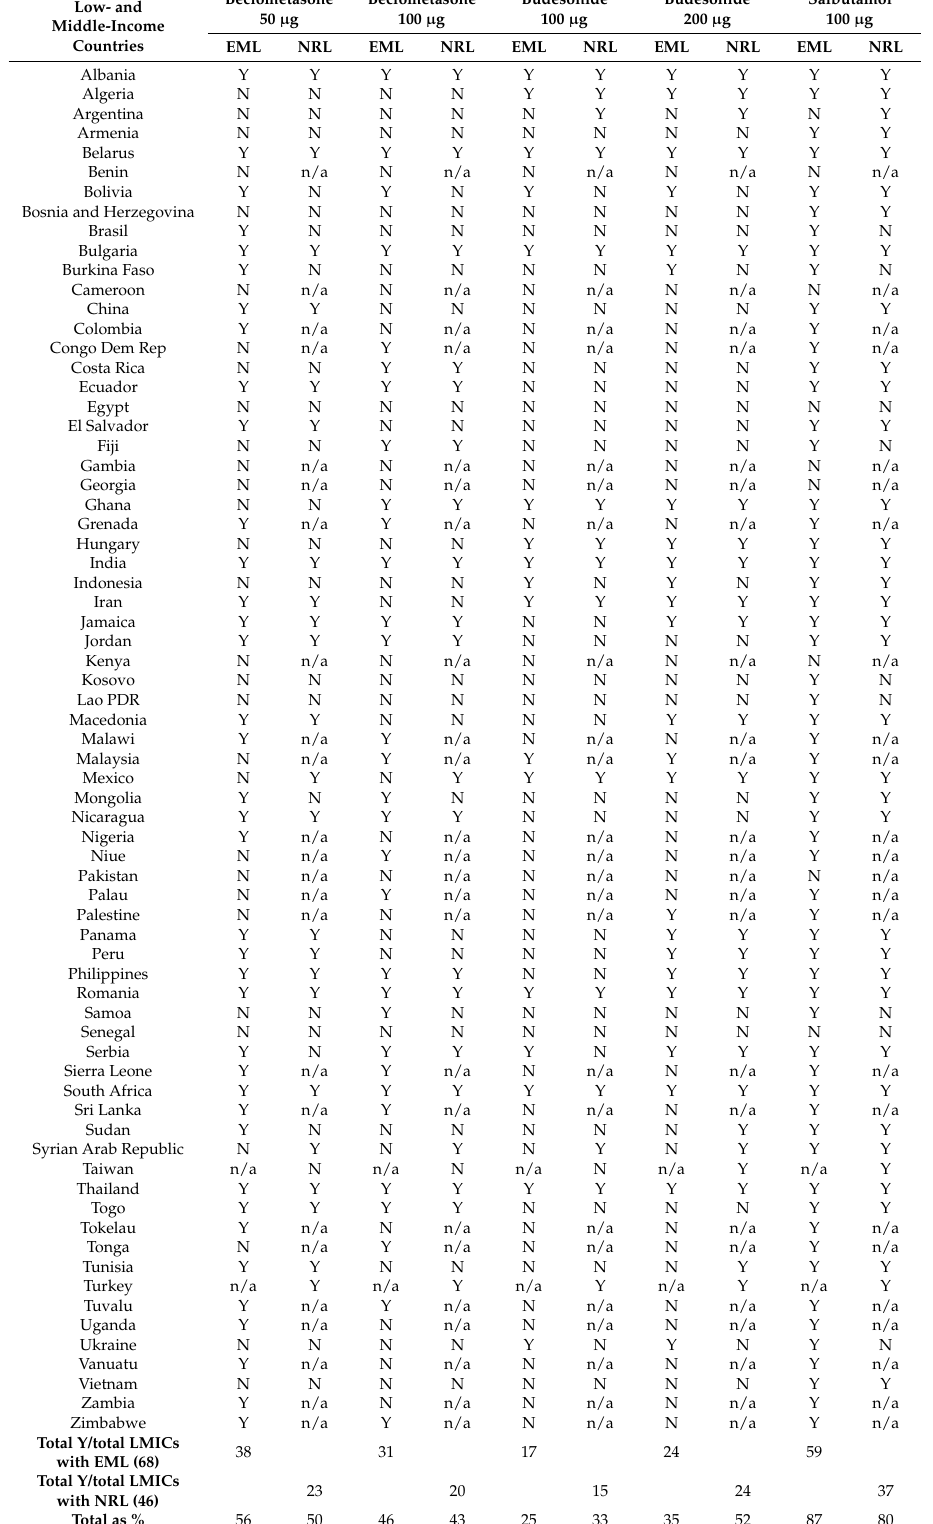
Table 4. Inclusion of HFA inhalers from the WHO Essential Medicines List in National Essential Medicine and National Reimbursement Lists in 70 low- and middle-income countries, 2014 *. Low- and